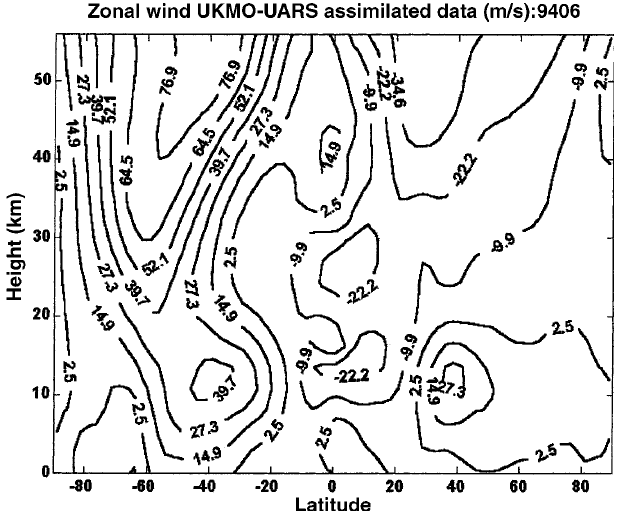
Fig. 4. Latitude-height section of zonal wind profile of June 1994 based on UKMO-UARS